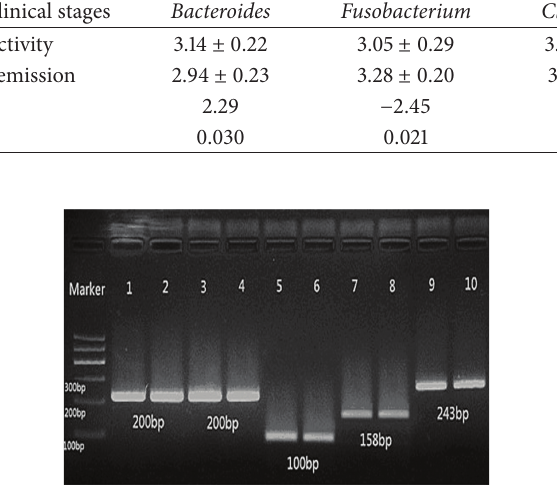
Figure 1: Electrophoretic gel image of five kinds of